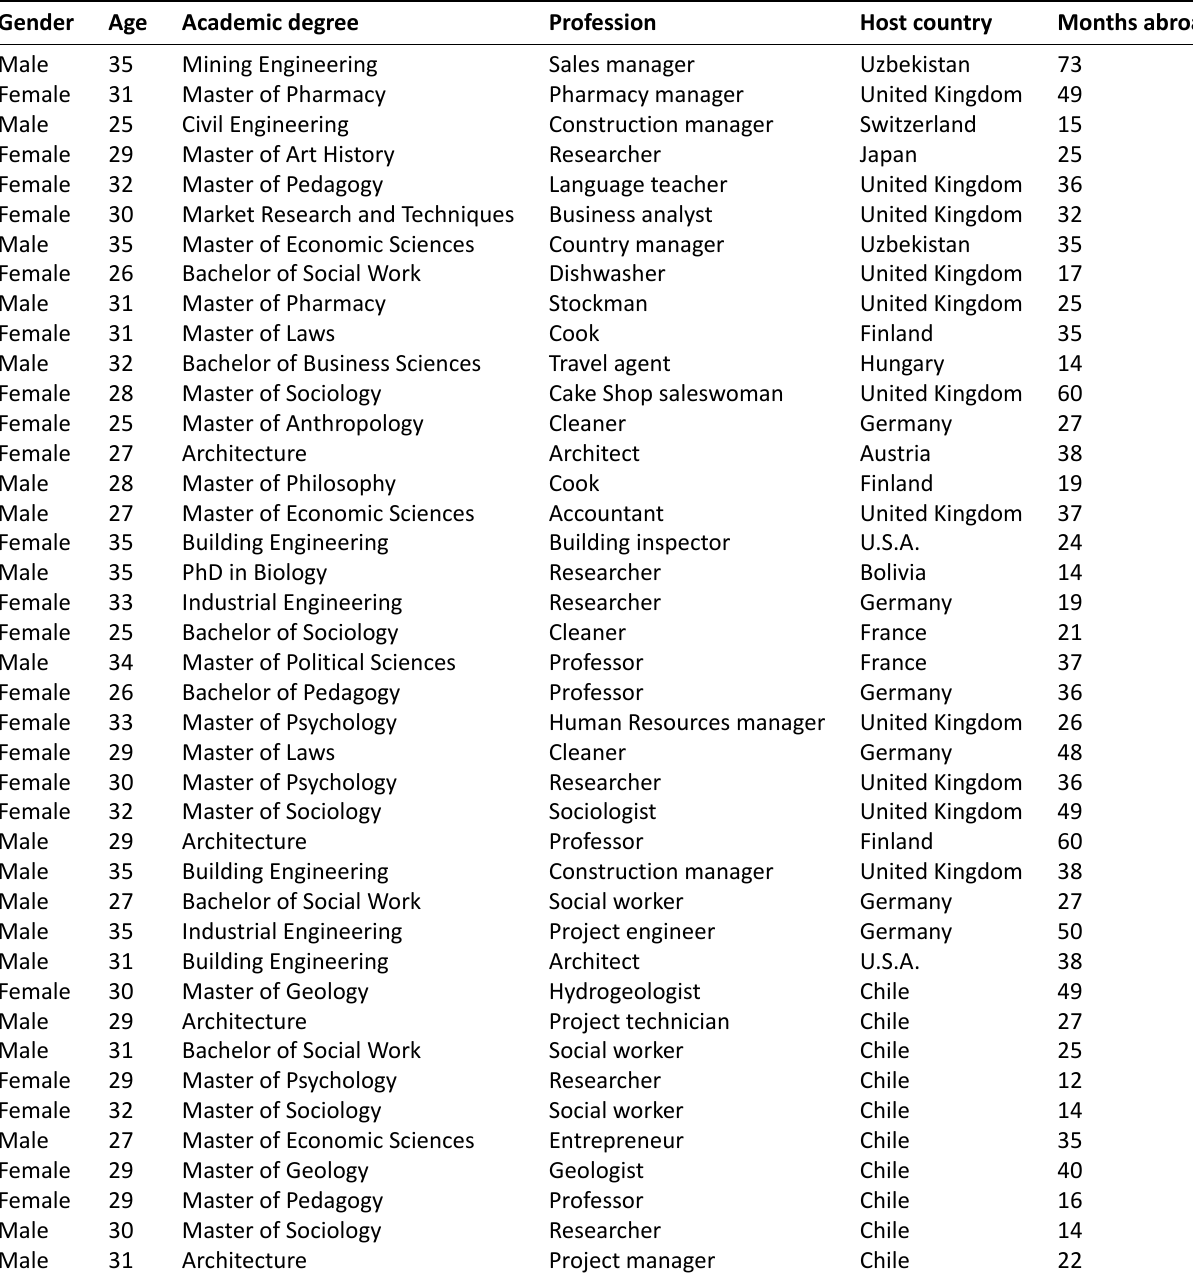
Table 1. Profiles of the interviewees.